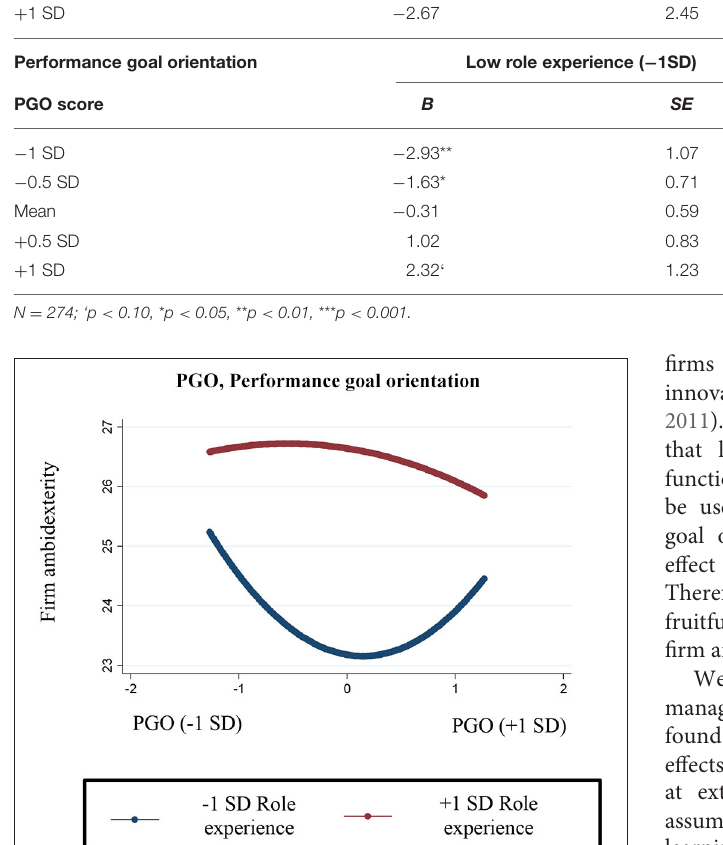
makers, their goal orientations. Just as ambidexterity